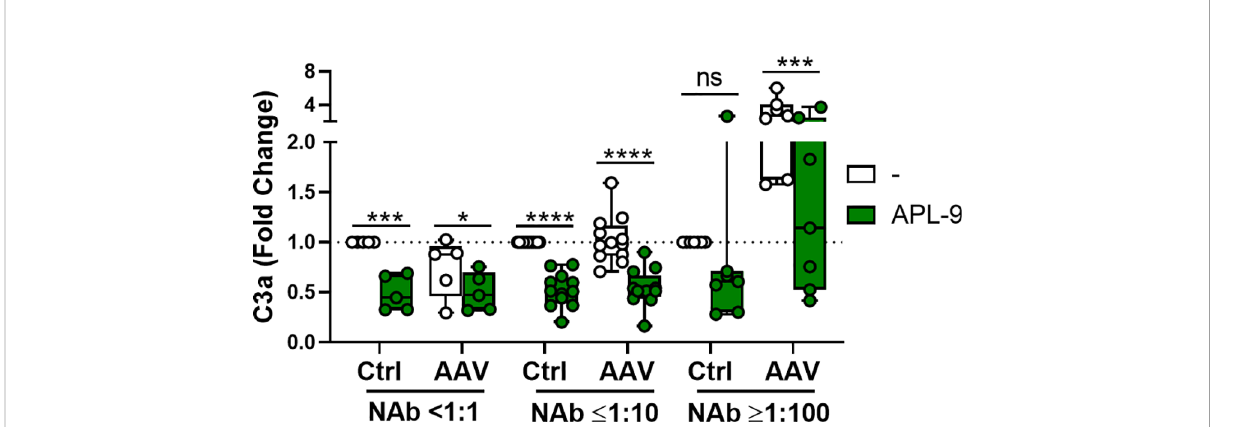
FIGURE 7 APL-9 lowers complement activation in NAb-positive and negative blood. C3a levels in whole blood measured 90 minutes post AAV-Spark100 (5×10 11 vg/mL) addition with or without APL-9. Bars represent the mean fold change ± SEM relative to unstimulated cells. Symbols represent the individual values in samples. Signi fi cance was determined with a two-way RM-ANOVA with Sidak ’ s multiple comparison test. *p ≤ 0.05; ***p ≤ 0.001; ****p ≤ 0.0001. ns, not signi fi